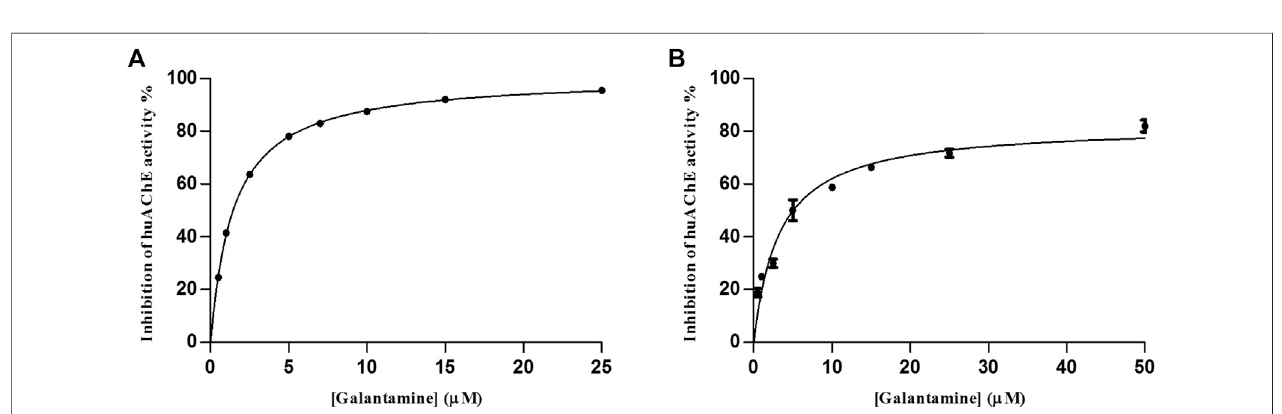
FIGURE 4 | Inhibitory potency curve obtained for huAChE-ICER by using ACh as a substrate. (A) mobile phase pH 4.5 and (B) mobile phase pH 8.0. See Table 1 for conditions.